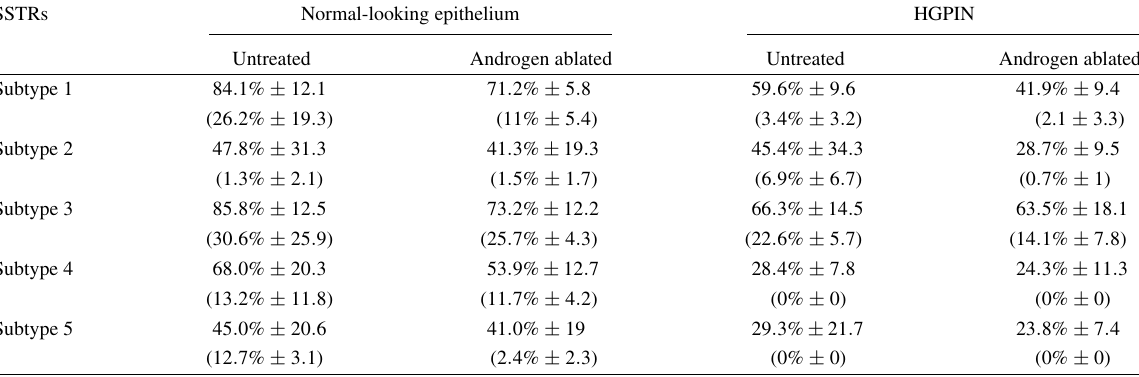
Percentages (mean ± standard deviation) of basal cells with positive cytoplasmic staining